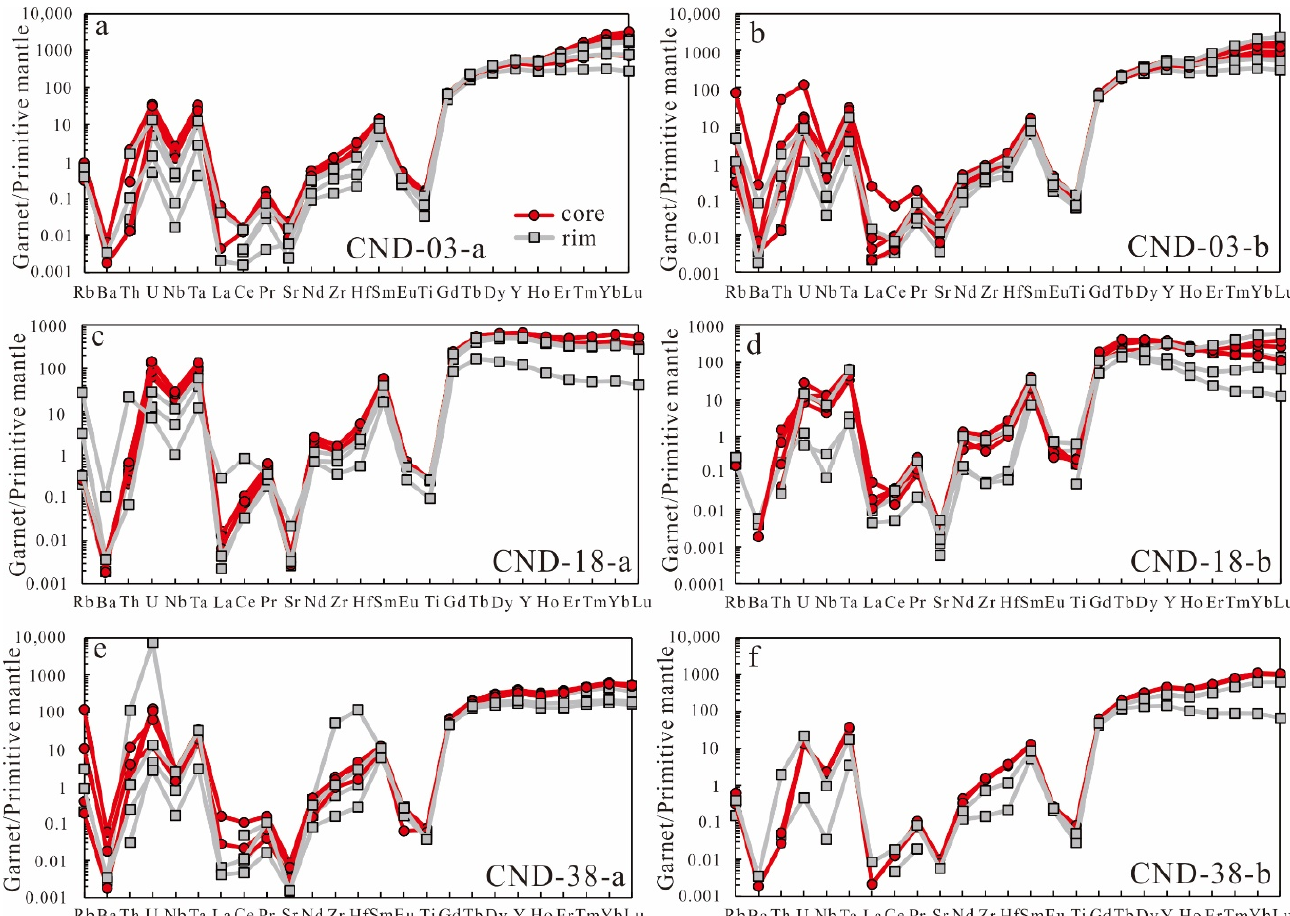
Figure 5. Primitive mantle-normalized trace element spider diagrams of garnets. ( a , b ) garnets from the muscovite granite; ( c – f ) garnet grains from the pegmatite (primitive mantle normalization data from [63]).